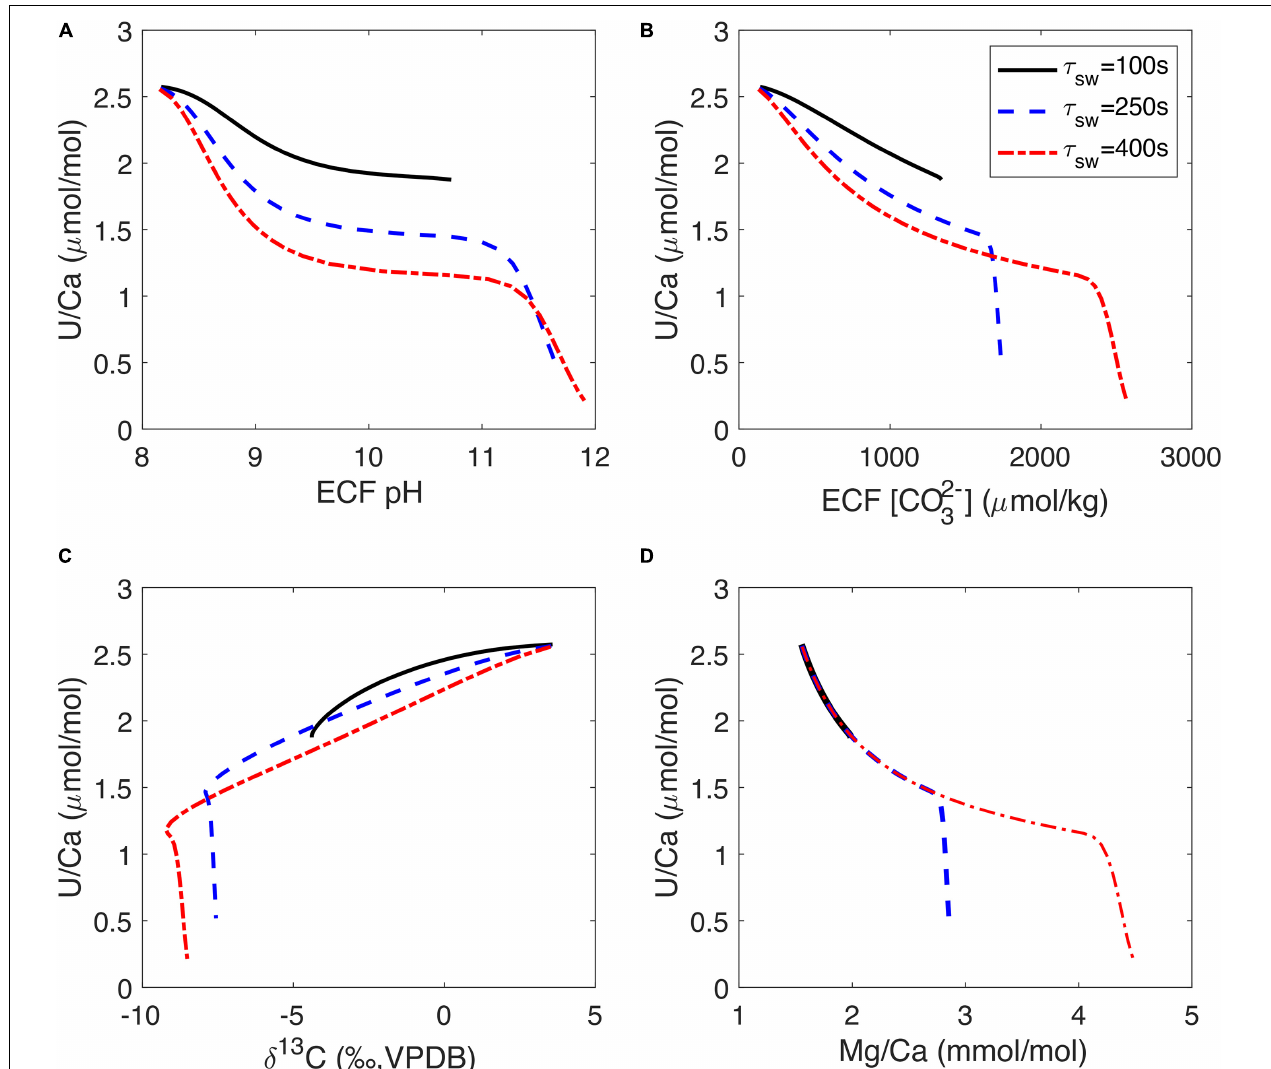
FIGURE 8 | U/Ca model sensitivity to seawater turnover timescale ( τ sw ) in the ECF. Panels (A–D) show U/Ca relations with ECF pH, ECF [CO 32 - ], skeleton δ 13 C and Mg/Ca respectively. In panel (D) , the three curves overlap on the low Mg/Ca high U/Ca end. Three curves correspond to different seawater turnover timescales in each panel simulated over the same range of alkalinity pump rates. The model curves are generated with f Ca = 0 and assuming Ca 2 UO 2 (CO 3 ) 3 is the incorporated uranium species (as in Figure 7 Column 5).